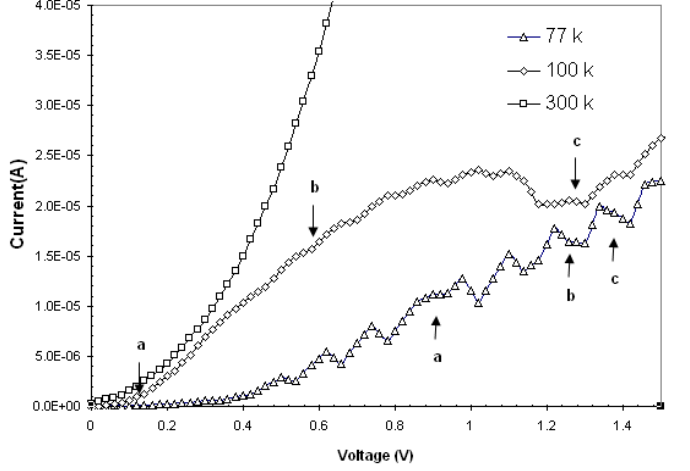
Figure 5 . Comparison of I-V curves of PtSi/PS/PtSi structure at 77, 100 and 300 K